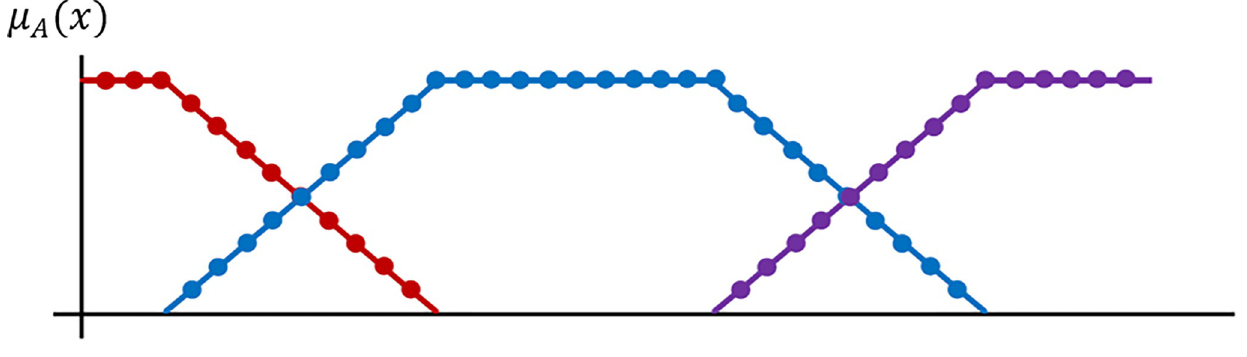
Fig 1. Components’ membership of groups „strong”, „medium”, „weak”.